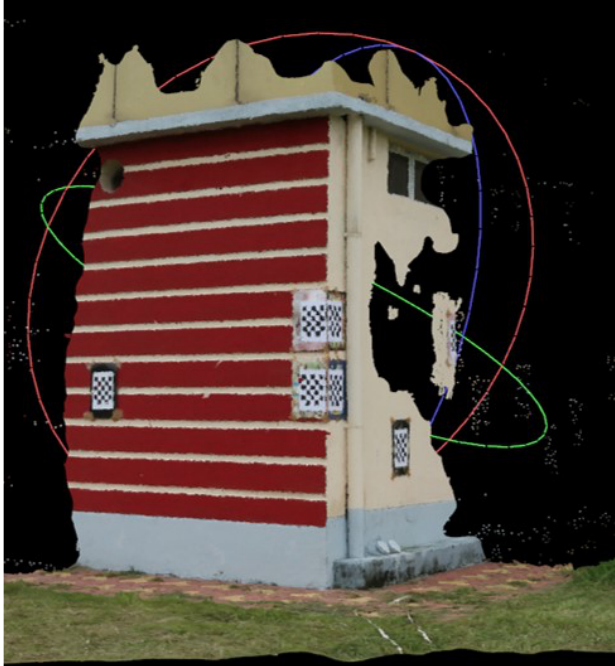
Figure 9: 3D mesh model of 90°